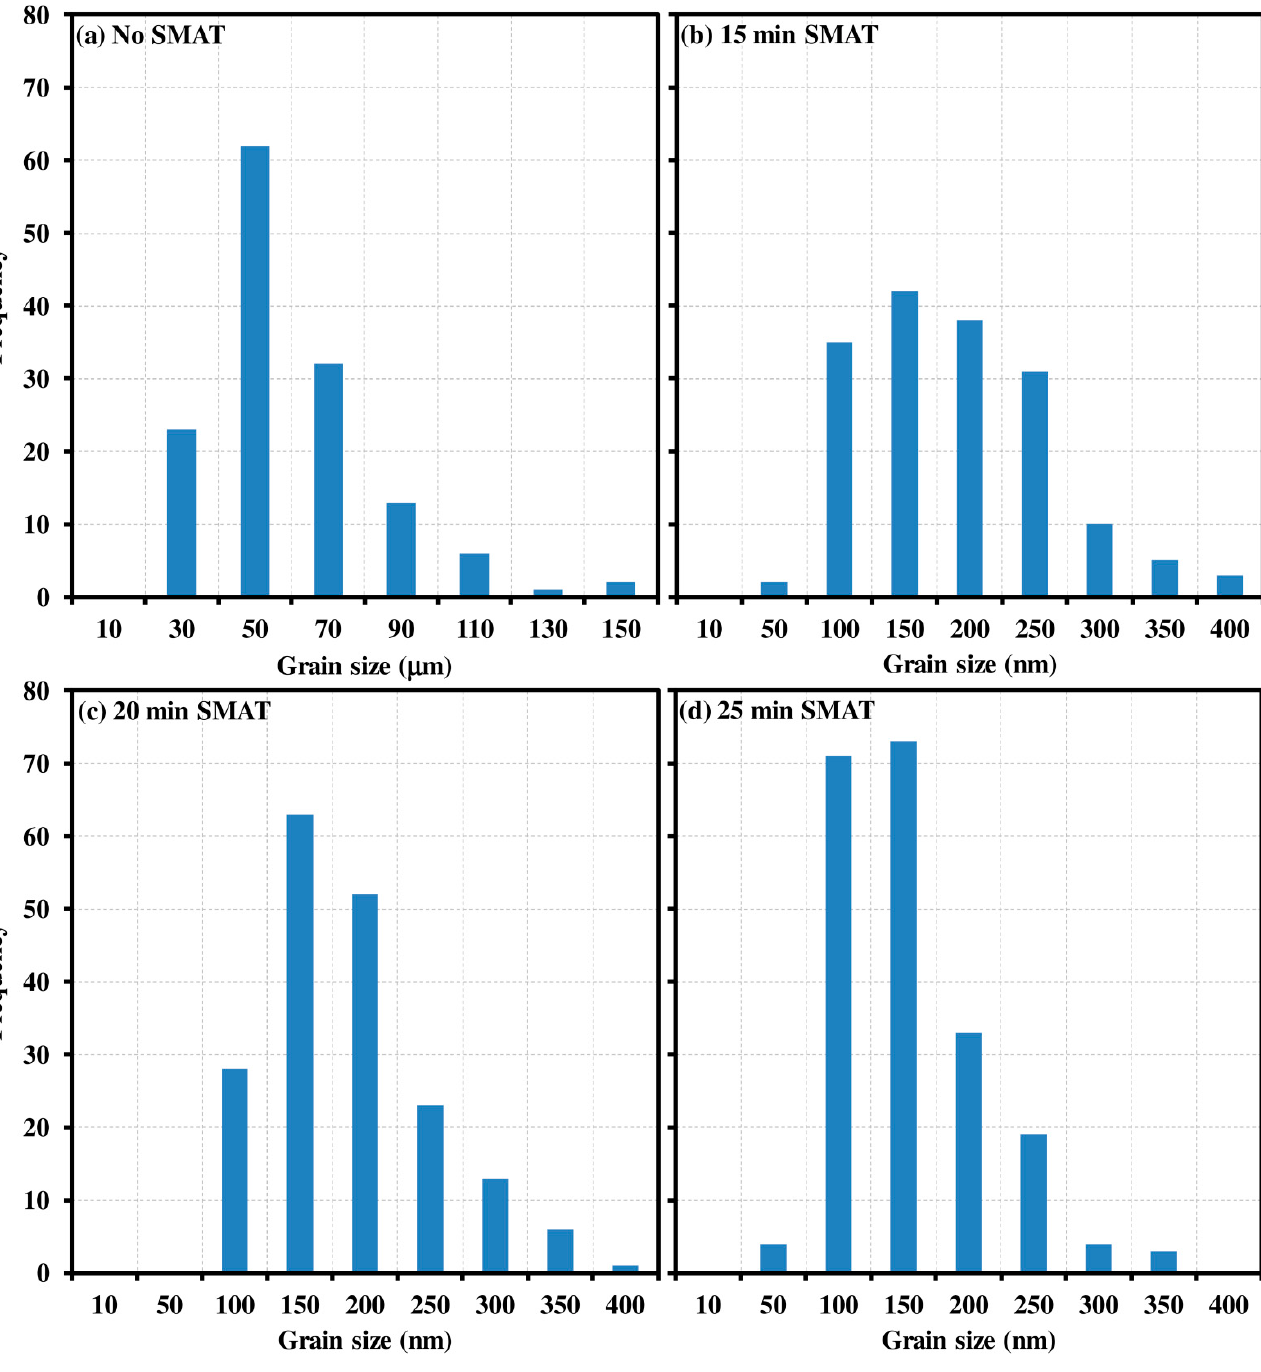
Figure 5. Grain size frequency distribution of: ( a ) untreated Ti; SMAT-modified samples treated for: ( b ) 15 min; ( c ) 20 min and ( d ) 25 min.